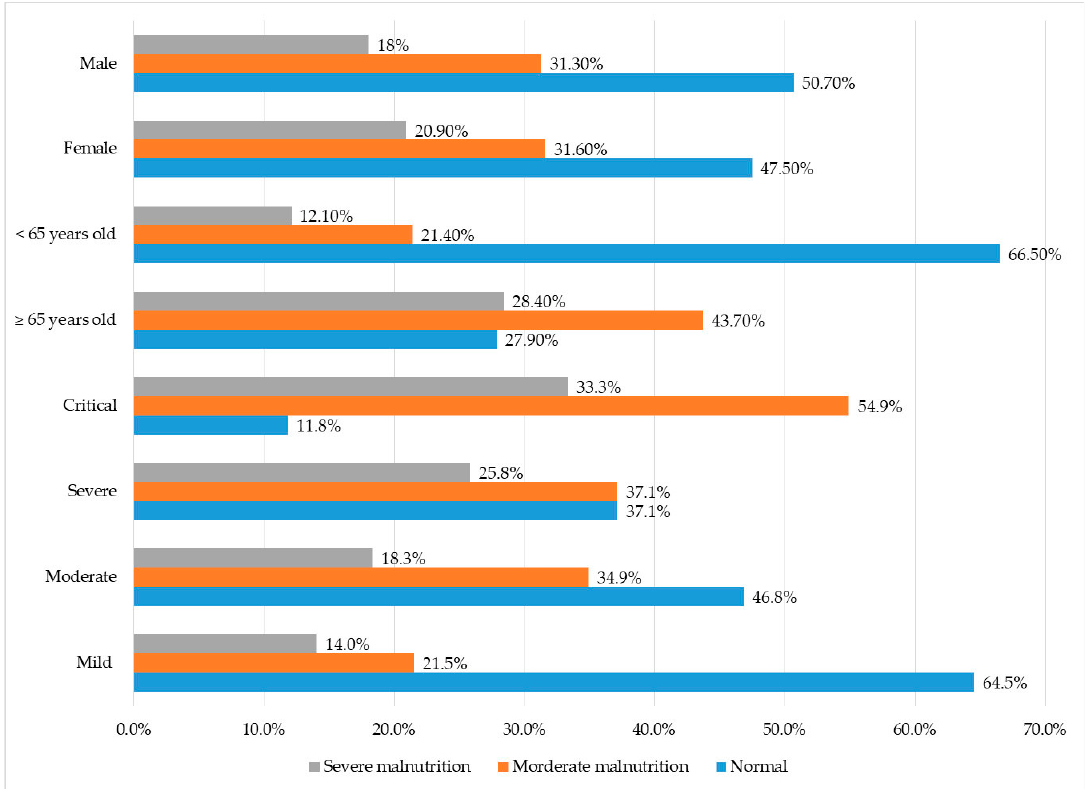
Figure 2. The percentage of malnutrition according to severity of COVID-19, gender and age. Table 2 indicates that serum albumin decreased paralelly to the severity of COVID-19. the difference was statistically significant. Mean value of sodium and potassium in all levels of the disease were significantly different. but serum sodium was not decreased according to the severity. and potassium climbed following the severity. Even though there were not any statistical difference of mean value of pre-albumin, phosphorus and